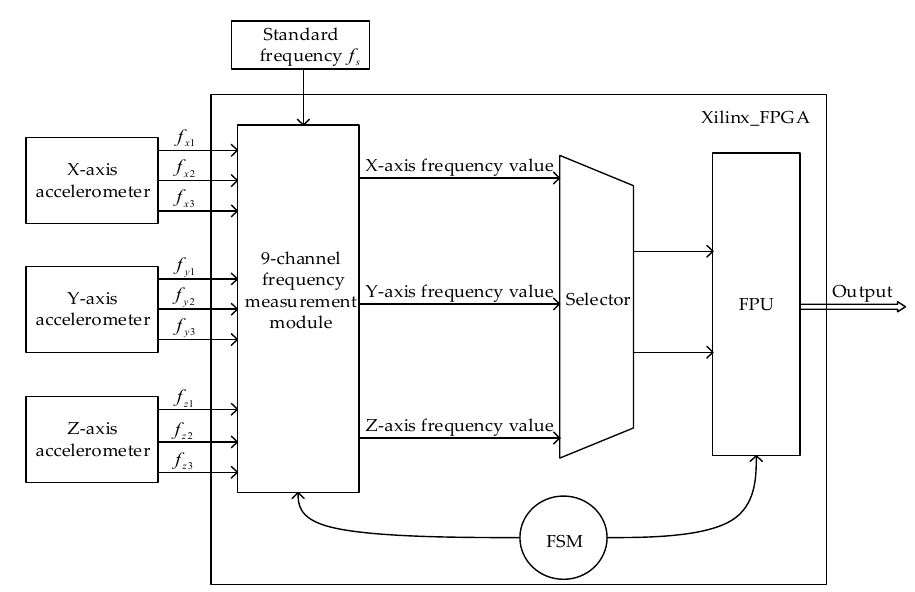
Figure 8. Quartz Vibrating beam accelerometer output and acquisition system.